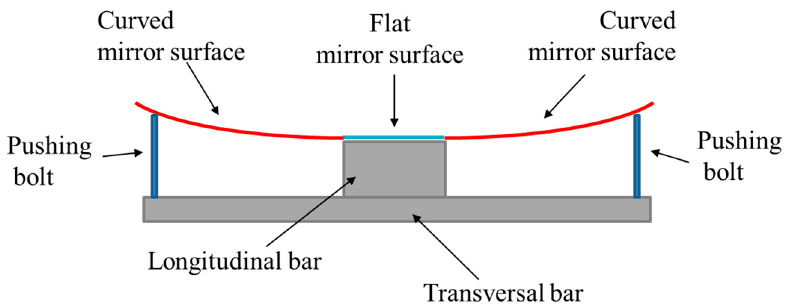
Figure 10. Scheme of transversal section of naked mirror mechanically bended by metallic bars glued